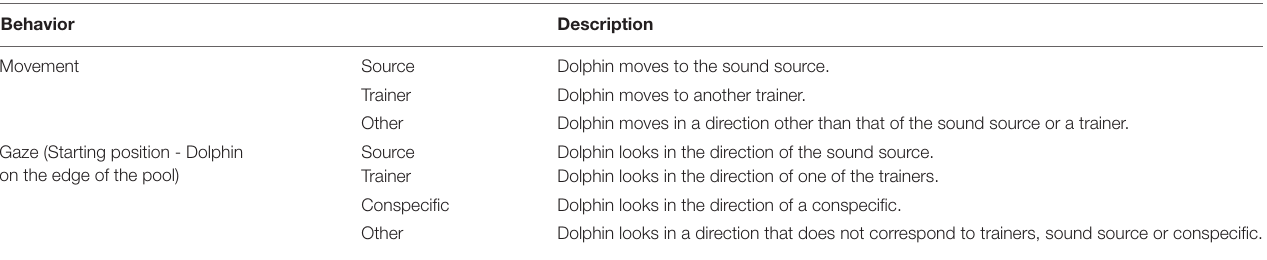
TABLE 2 | Terminology of behaviors observed during the